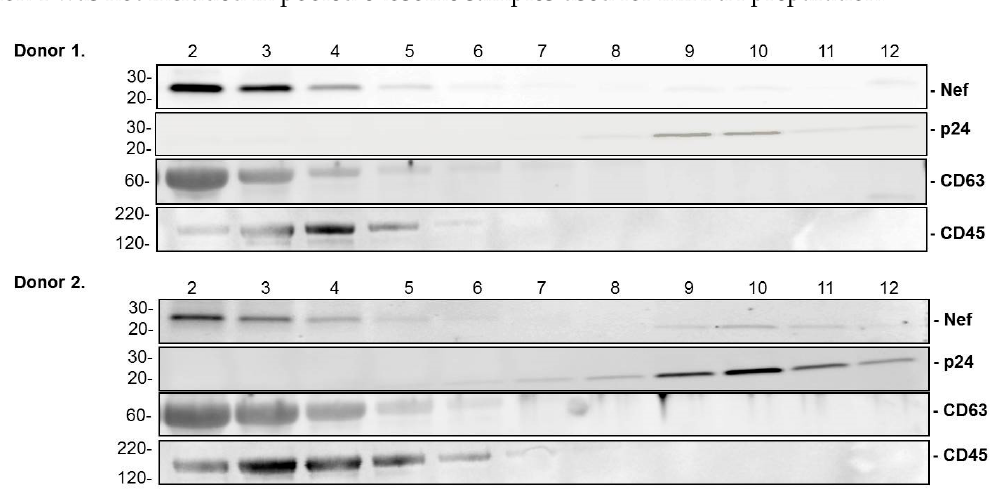
Figure 2. Western blotting of proteins in exosome preparations from HIV-1-infested MDM. The proteins in individual iodixanol gradient fractions 2-12 from HIV-1-infected MDM from donors 1 and 2 were separated by SDS-PAGE and transferred to polyvinylidene fluoride (PVDF) membranes. The membranes were incubated with antibodies to exosomal proteins CD 45 and CD 63 and HIV-1 proteins p24 and